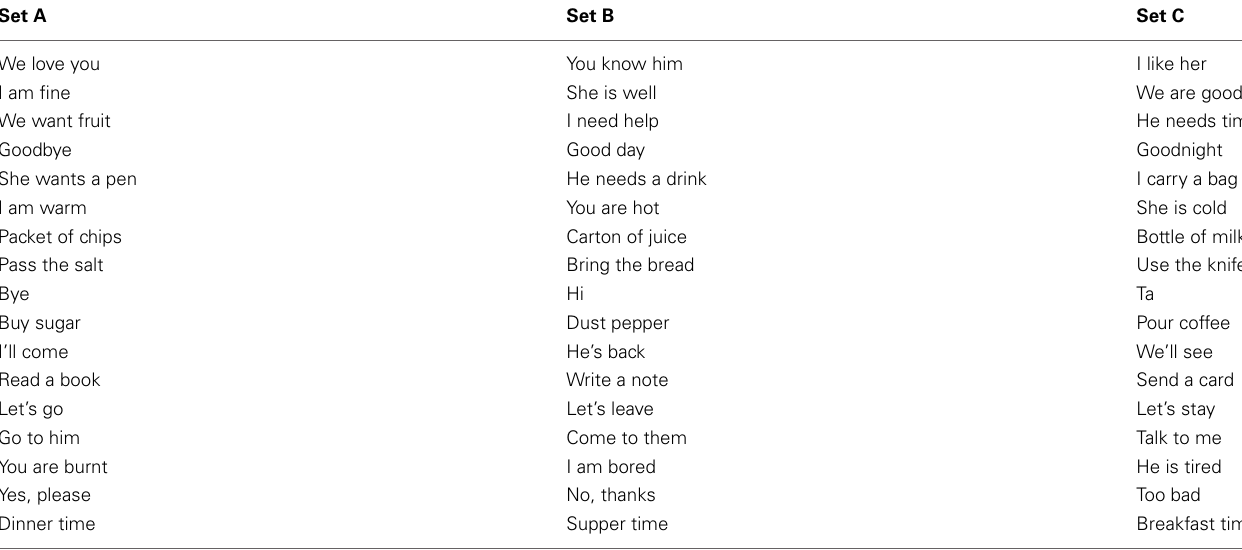
Table A1 | Phrases used during the phrase repetition